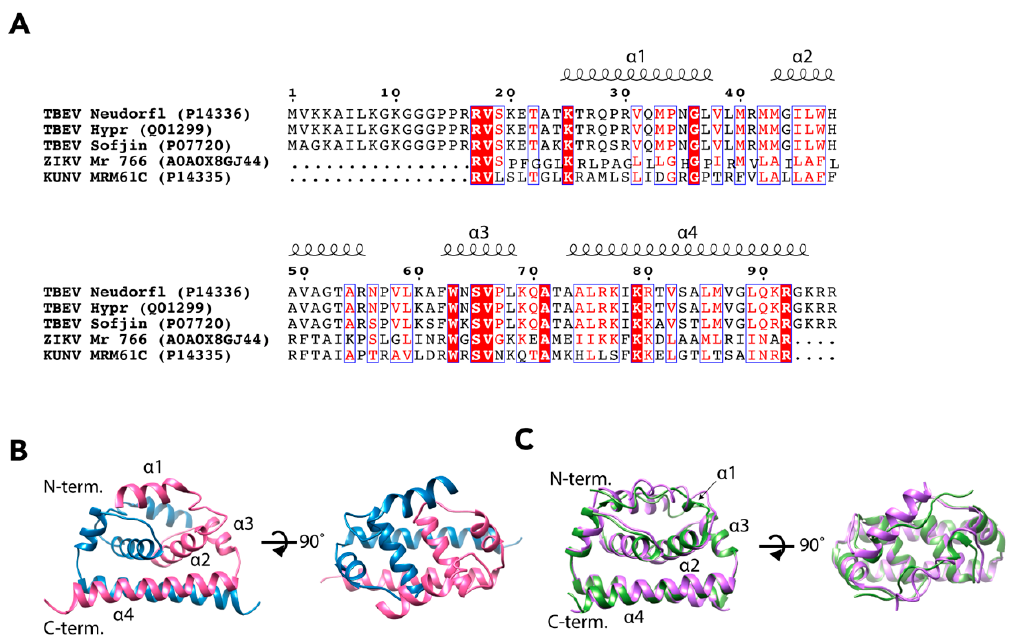
Figure 3. Comparison of the sequence and tertiary structure of flavivirus C proteins. ( A ) Sequence alignment of C proteins from TBEV, ZIKV and KUNV. UniProt accession numbers are shown in brackets. The alignment has been done using the Espript 3.0 web server (http://espript.ibcp.fr, [45]). White characters in red boxes highlight identical residues, red characters in blue boxes indicate residues with equivalent physico-chemical properties. Residues forming α -helices (based on the KUNV C structure) are indicated above the sequences. ( B ) Ribbon representation of a TBEV C dimer homology model (residues 24–96) built using the I-TASSER web server (C-score = − 0.77) with the ZIKV C structure (wwPDB: 5YGH) as a template. The predicted positions of the α -helices are indicated. ( C ) Comparison of C-protein structures from ZIKV (green, wwPDB ID: 5YGH) and KUNV (violet, wwPDB ID: 1SFK). Positions of α -helices are indicated. The C protein of TBEV consists of 96 amino acid residues (UniProt: Q01299, P14336, and P07720)